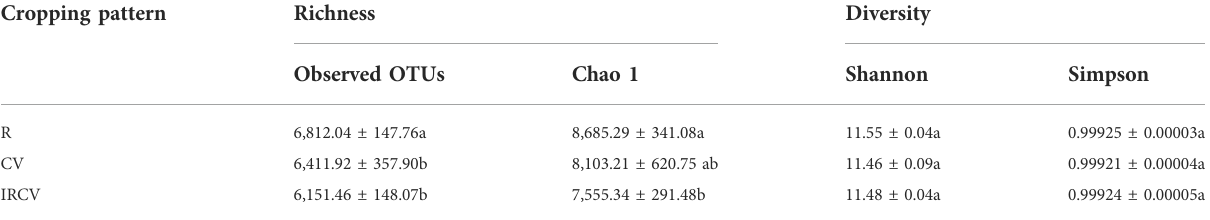
TABLE 3 Richness, diversity of the bacterial communities of the rhizosphere soil under different treatments. Cropping